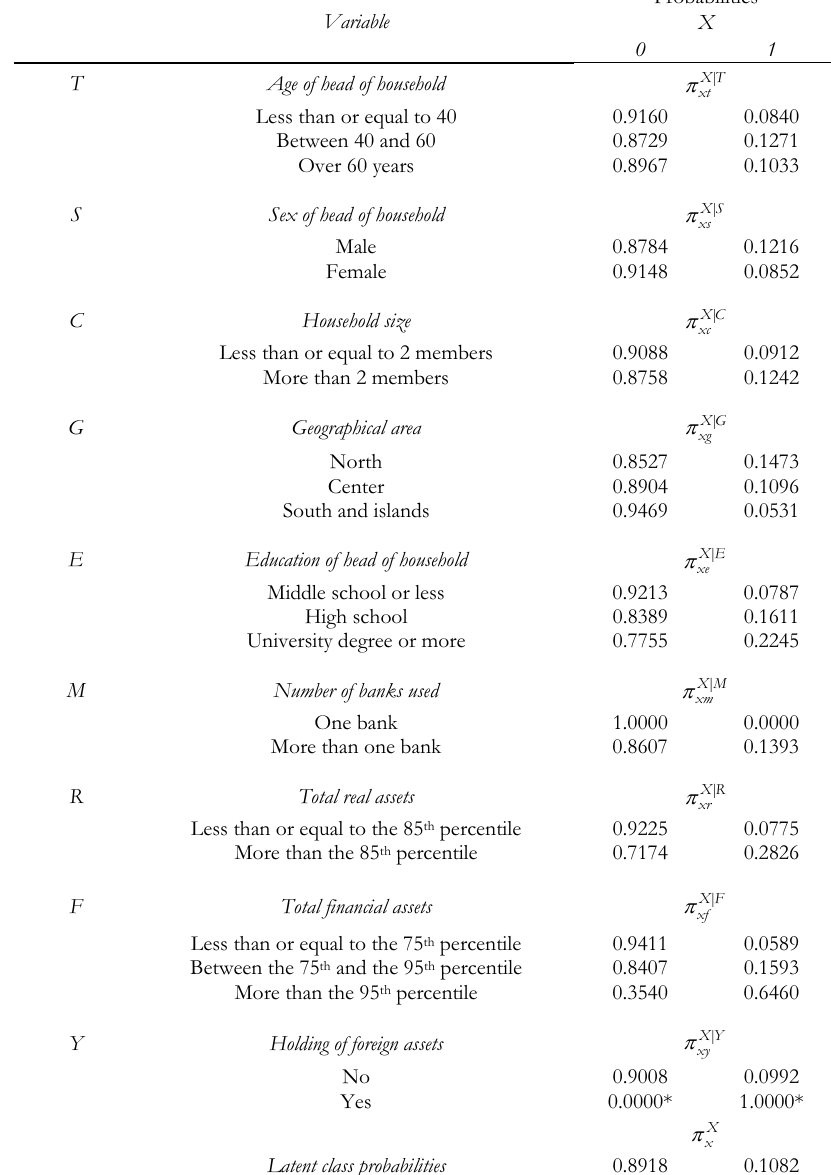
Posterior probabilities of class membership - model 6 estimated on 2002 SHIW data (*: restriction improsed)